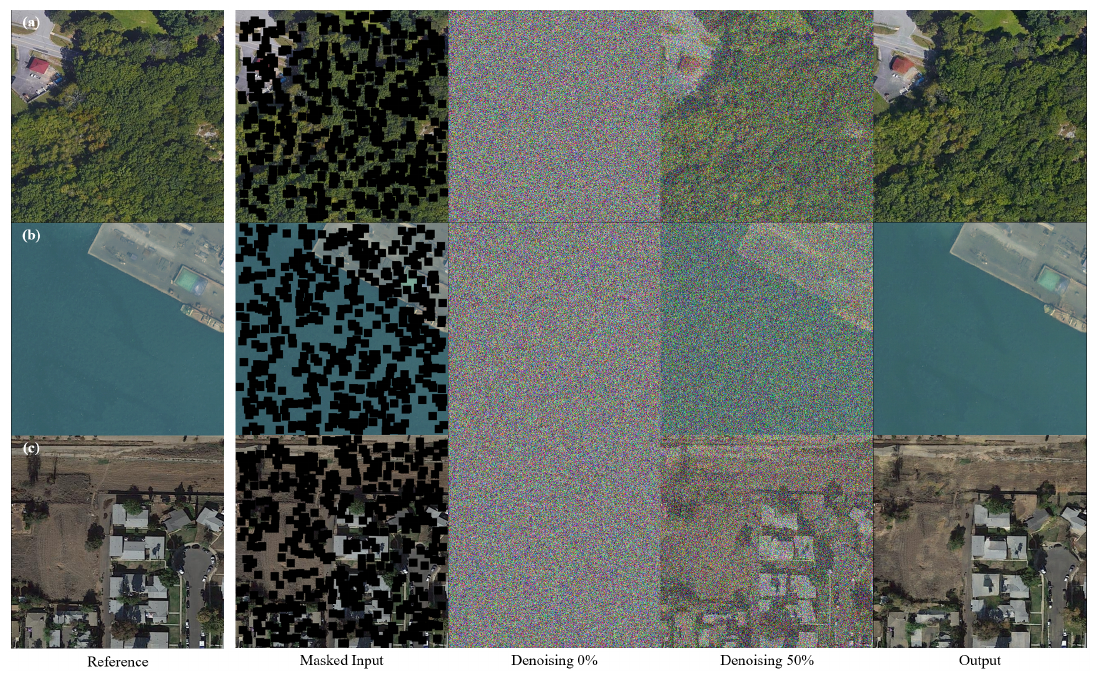
Figure 4. ( a – c ) are the visualizations of the detail complementation process of the FAIR dataset, respectively. Reference (Column 1) shows the source images. The masked input (Column 2) is the result of random mask X with small squares, and Columns 3–5 are the HR image generation